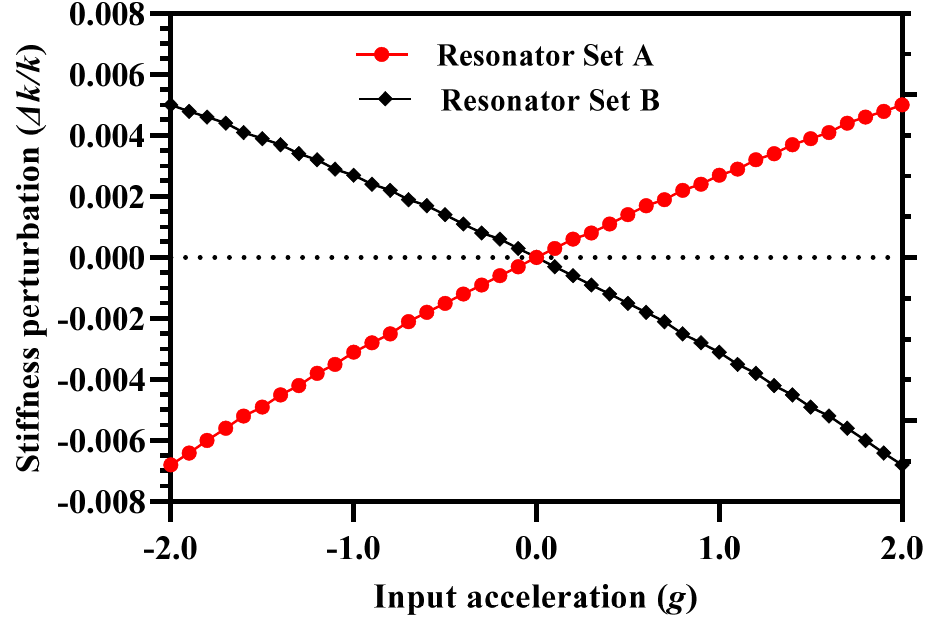
Figure 4. Normalized stiffness perturbation in the inner resonators of 3-DoF resonator sets for an input acceleration in the range of ±2 g.